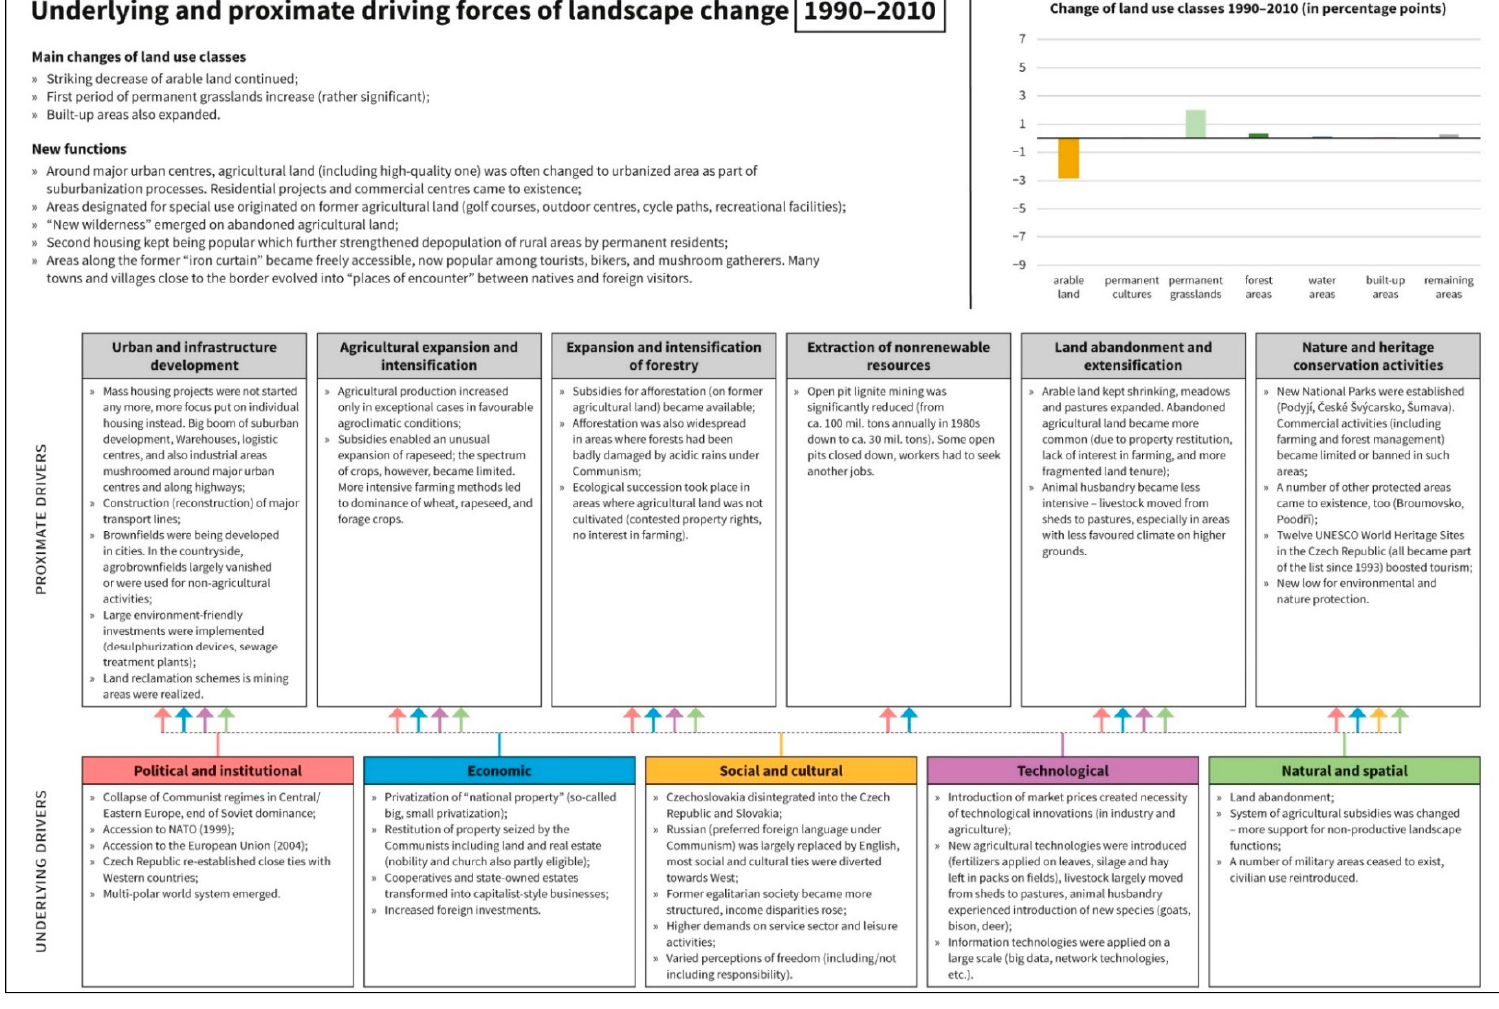
Figure A4. Underlying and Proximate Driving Forces of Landscape Change 1990–2010